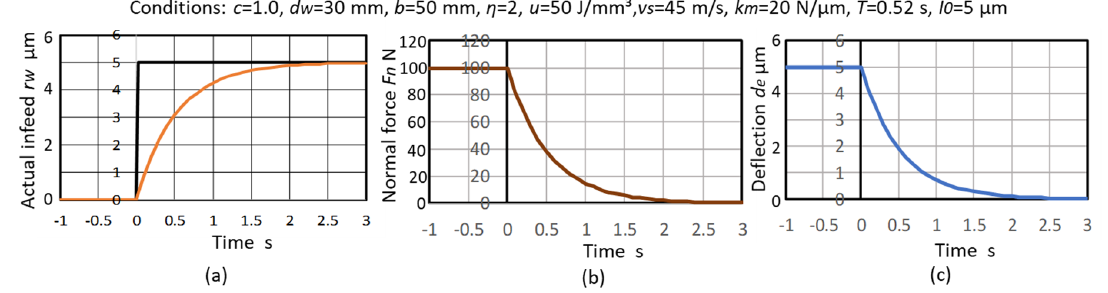
Figure 9. Responses to step infeed in cylindrical infeed grinding (spark-out grinding). ( a ) Actual infeed I 0 = 5 μm; ( b ) Normal grinding force F n (0) = 99.8 N; ( c ) Machine deflection d e (0) = 5μm.